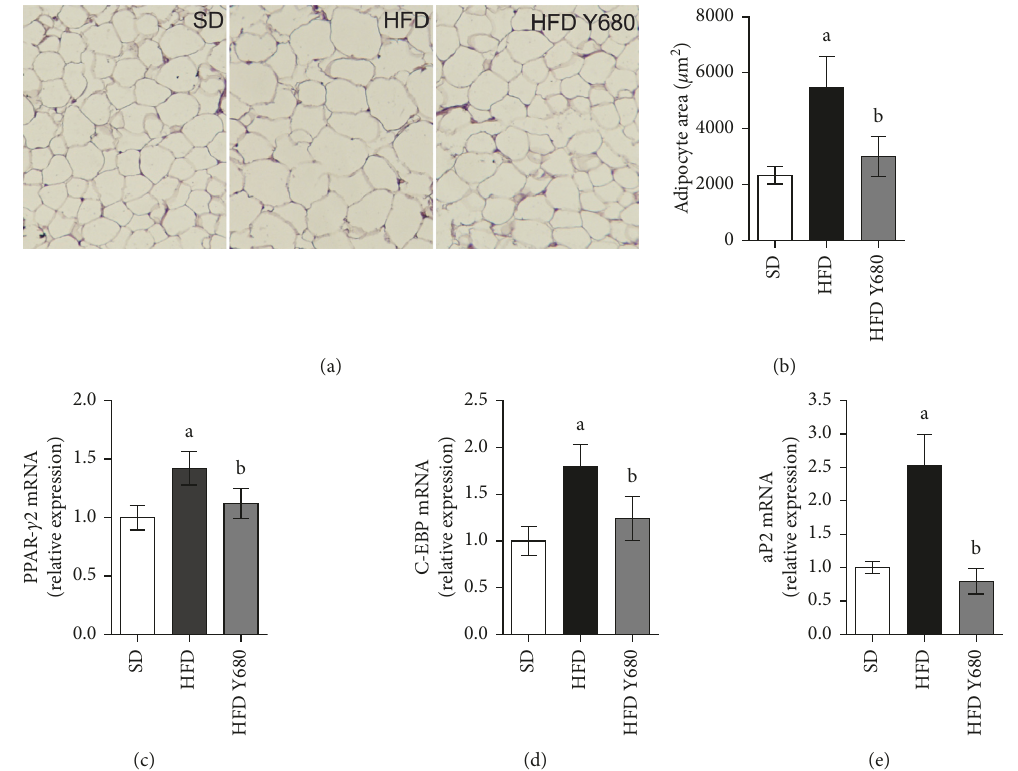
Figure 3: Effects of yacon flour on the adipose tissue of HFD-fed rats and adipogenesis-related genes. (a) Representative photomicrographs of visceral adipose tissue sections stained with H&E (original magnification 126X). (b) Adipocytes size in visceral adipose tissue. qPCR analysis of visceral fat from rats fed standard diet (SD) or high-fat diet (HFD) supplemented or not with yacon flour (680 mg FOS/kg body weight: HFD Y680) after 8 weeks of treatment: PPAR- c 2: peroxisome proliferator-activated receptor gamma2 (c); C/EBP-a: CCAA- T/enhancer-binding protein (d); aP2: activating protein 2 (e). Data were normalized to Actin mRNA and expressed as fold change over the SD rats. Values are presented as